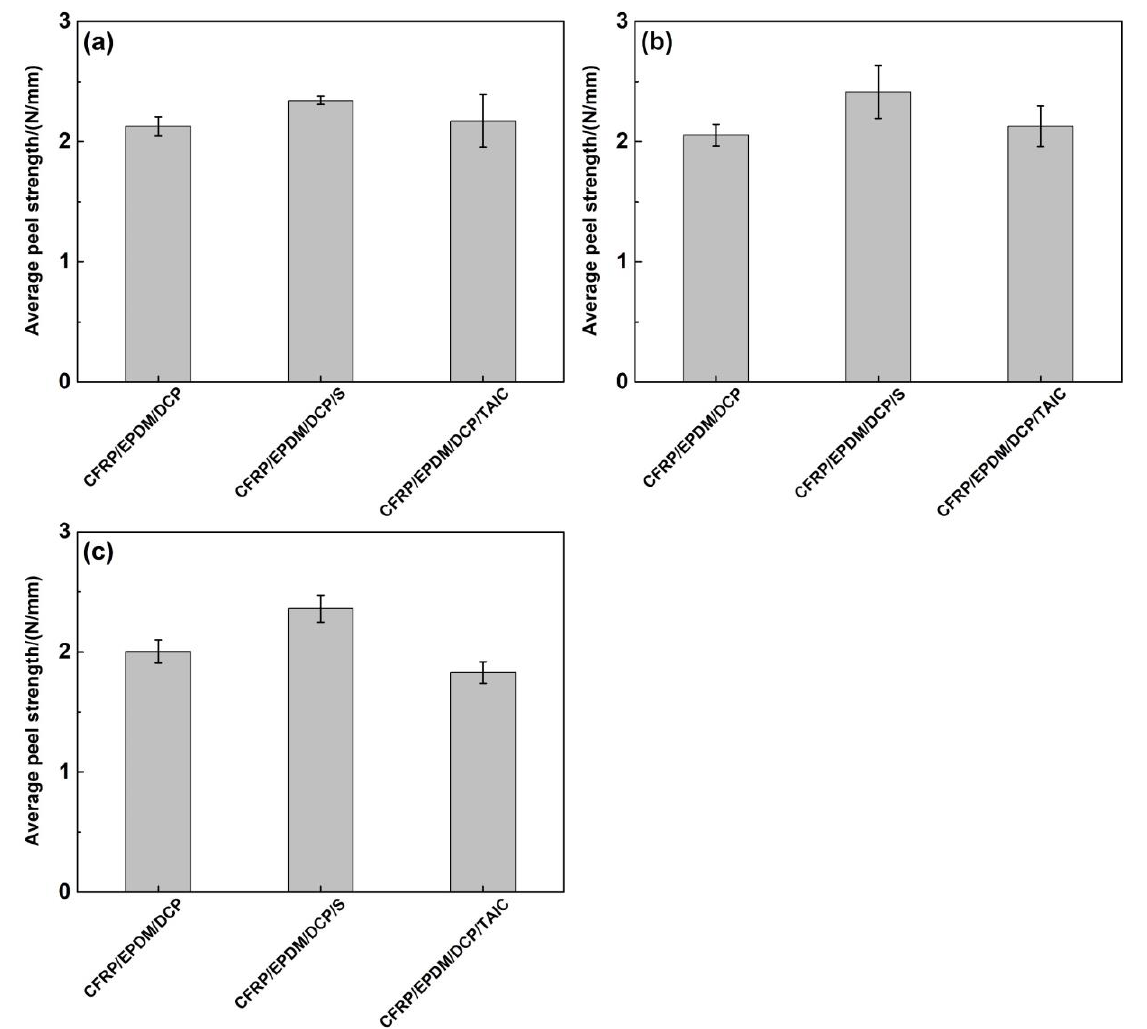
Figure 6. The average peel strength of CFRP/EPDM composites. ( a ) 160 °C, 20 min. ( b ) 160 °C, 30 min. ( c ) 160 °C, 40 min.